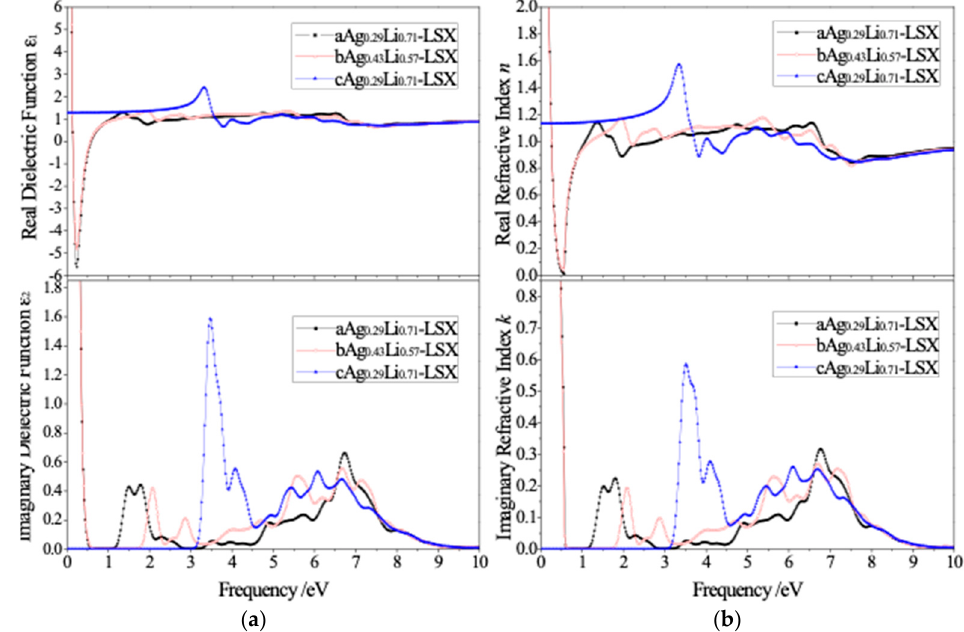
Figure 5. The calculated spectra of ( a ) dielectric function and ( b ) optical refractive index for Ag- exchange Li-LSX with the unpolarized light being incident along [001] crystallographic